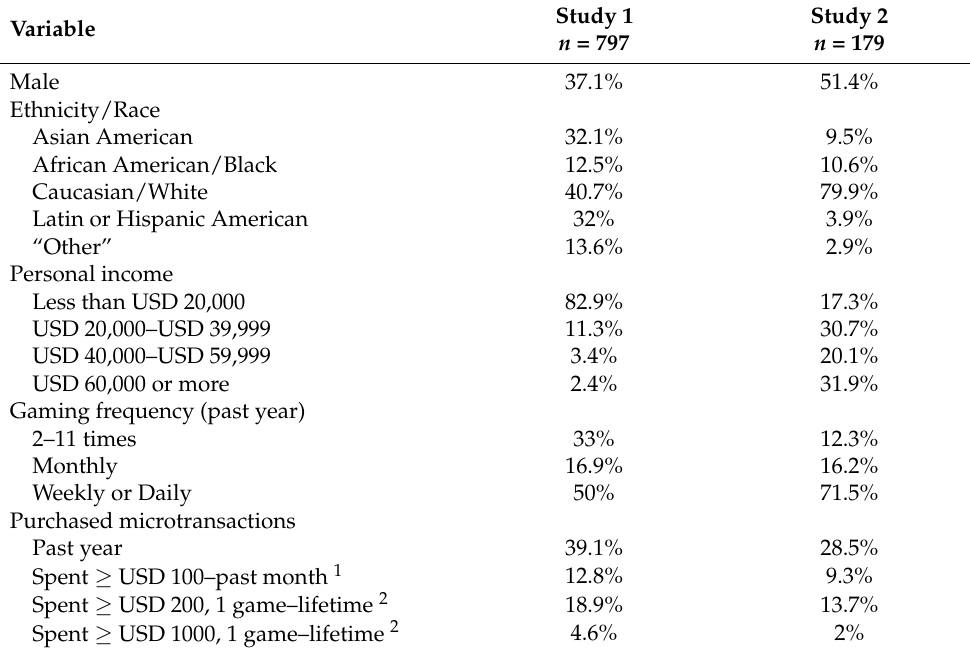
Table 1. Demographic characteristics and video game frequencies for Study 1 and Study